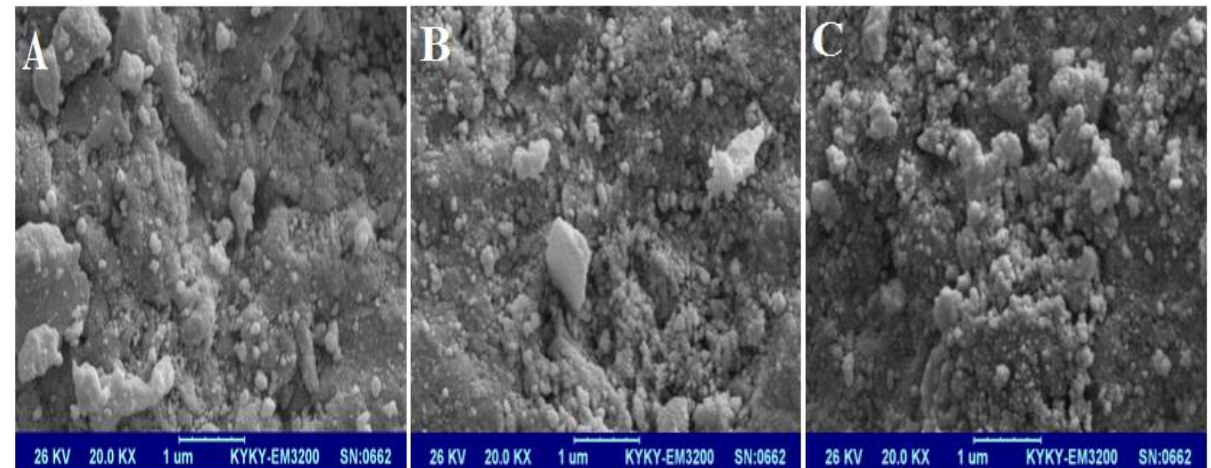
Figure 4. A: Scanning electron microscope image related to composite of MCh/Fe-Zr nanoparticles before adsorption of metal ions, B: scanning electron microscope image related to composite of MCh/Fe-Zr nanoparticles after adsorption of copper, C: scanning electron microscope image related to composite of MCh/Fe-Zr nanoparticles after adsorption of